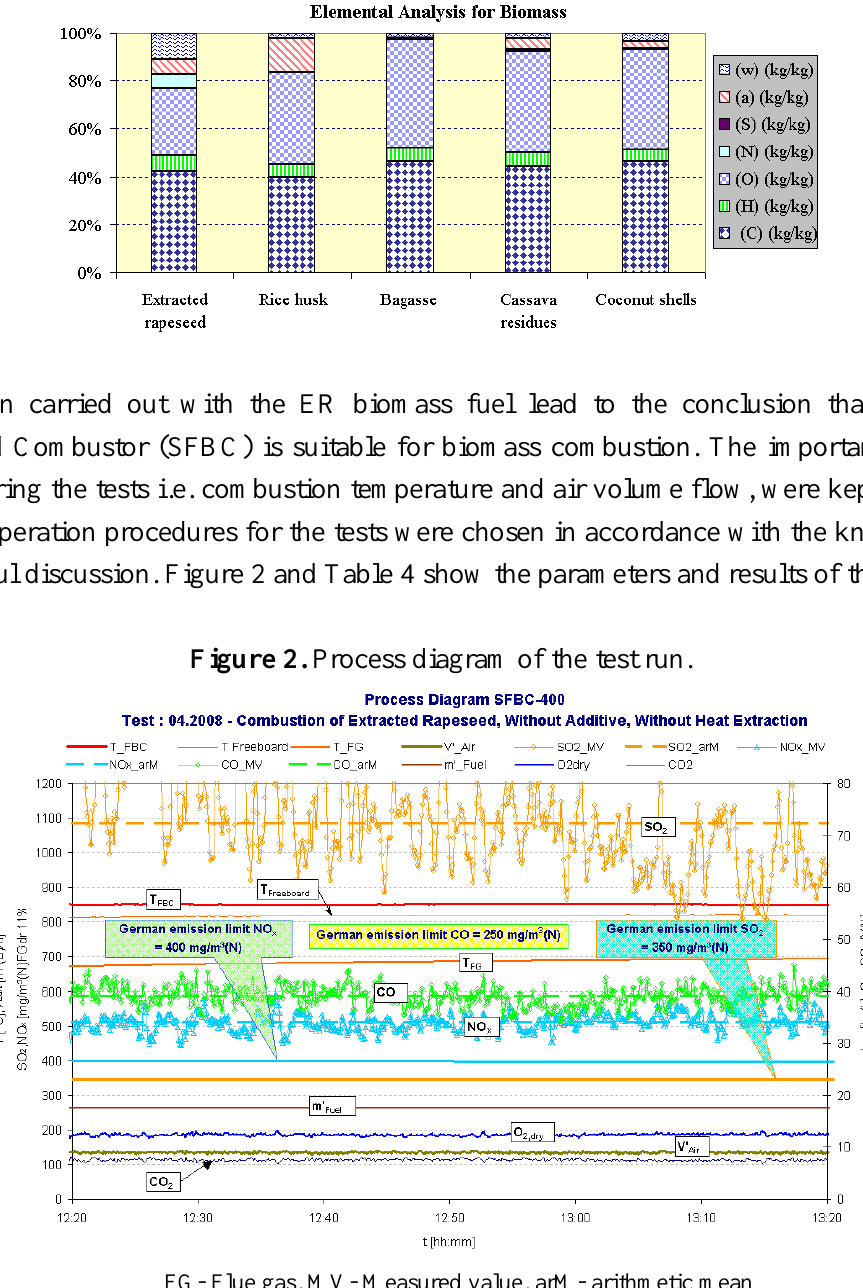
FG- Flue gas, MV- Measured value, arM- arithmetic